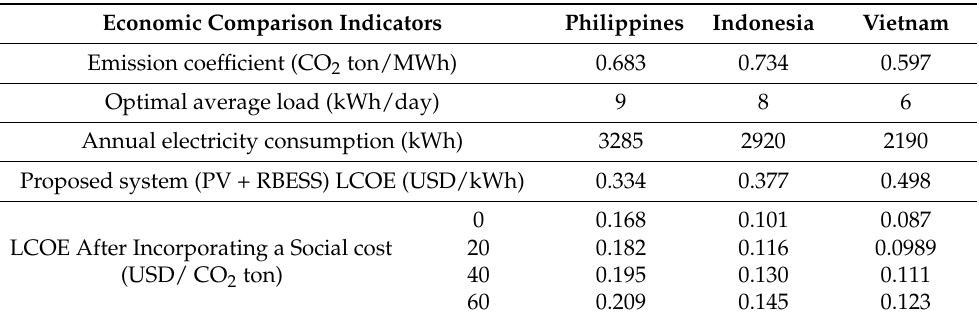
Table 18. Changes in LCOE of the Base 2 system (on-grid) after incorporating social costs (sensitiv- ity analysis).